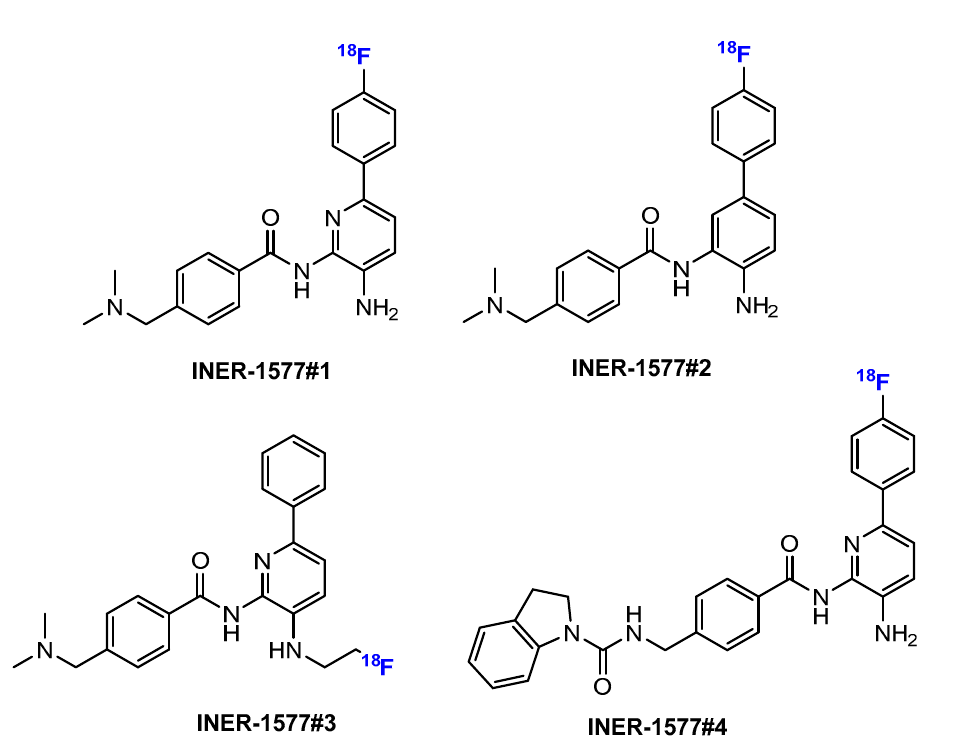
Figure 13. Chemical structures of four INER-1577 derivatives by Chen et al. [92].